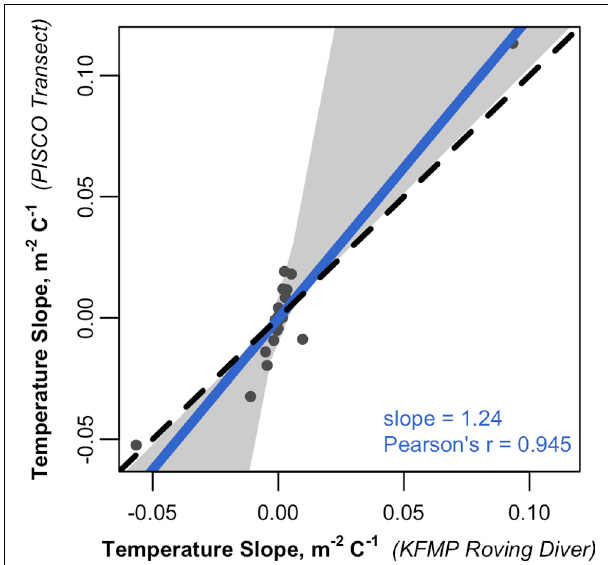
FIGURE 6 | Scatterplot comparing the slopes of the relationship between temperature and fish densities estimated from KFMP roving diver counts to those calculated from PISCO transect data. Each point is the slope of a least squares linear regression between sea surface temperature and the density of a species observed by both programs within the region ( n = 44; many dots are concentrated near the 0:0 point). The solid line represents a Deming linear regression and the dashed line represents the 1:1 line. The 0.95 confidence bounds are calculated with the bootstrap (quantile) method.